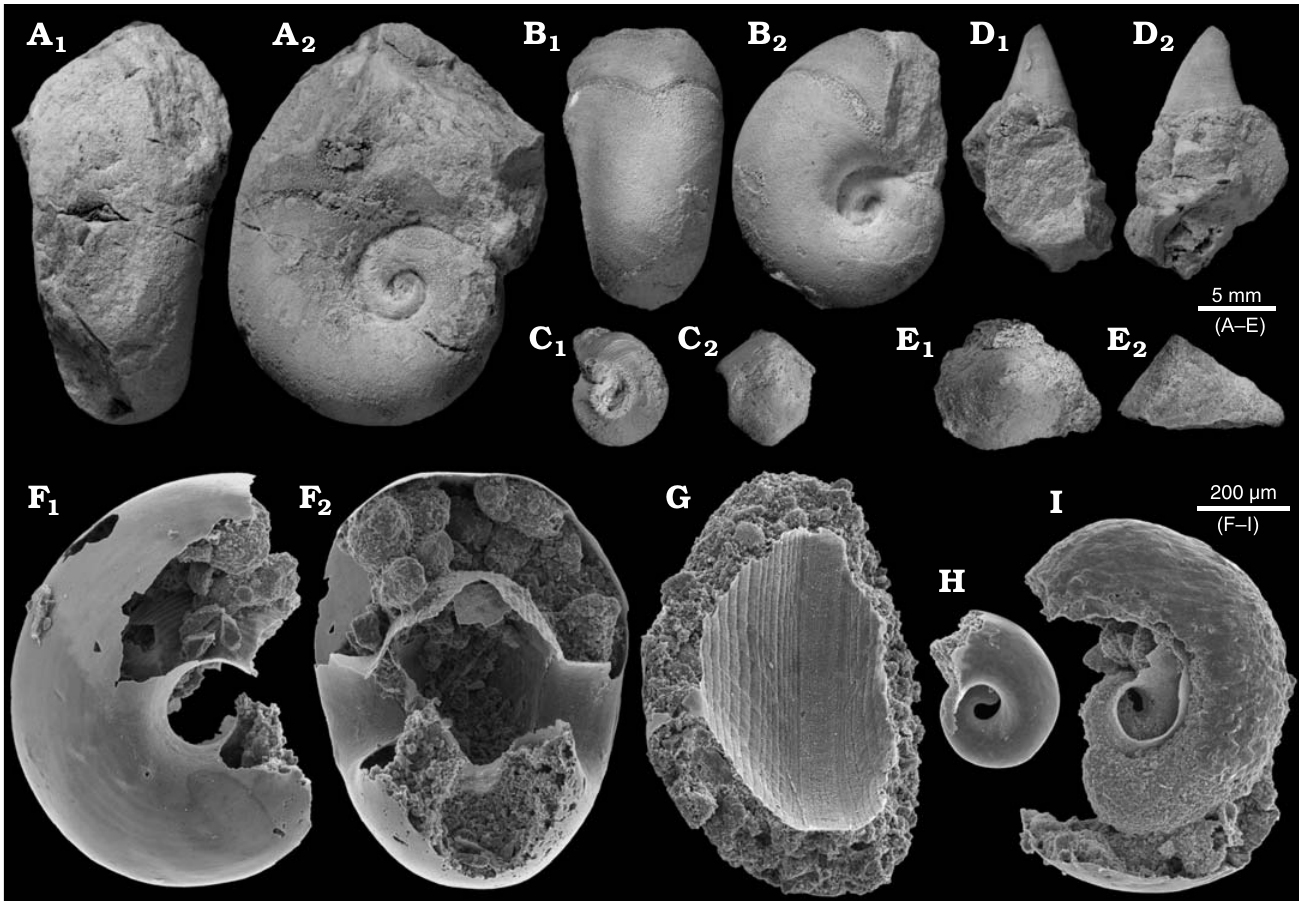
Fig. 4. Benthic bellerophontid and monoplacophoran molluscs from the probably latest Furongian Ust-kut Formation from the exposure at Pashino on the Angara River, Siberia, Russia; samples Ang-4, block No. 1 (A, B, D) and Ang-1, topmost limestone bed (C, E–I). A , B . Sinuitopsis sp. nov., ZPAL N. IV/154 and 155, in external (A 1 , B 1 ) and lateral (A 2 , B 2 ) views. C . Bellerophontid gen. et sp. nov. ZPAL N. IV/156, in lateral (C 1 ) and external (C 2 ) views. D . Hypseloconid ZPAL N. IV/157, in anterior (D 1 ) and lateral (D 2 ) views. E . Monoplacophoran? ZPAL N. IV/158, in dorsal (E 1 ) and lateral (E 2 ) views. F – I . Phosphatised conchs of juvenile individuals probably representing the same species as that on C; ZPAL NIV/162, 161, 160, and 159, respectively, in lateral (F 1 , H, and I) and apertural (F 2 , G) views.